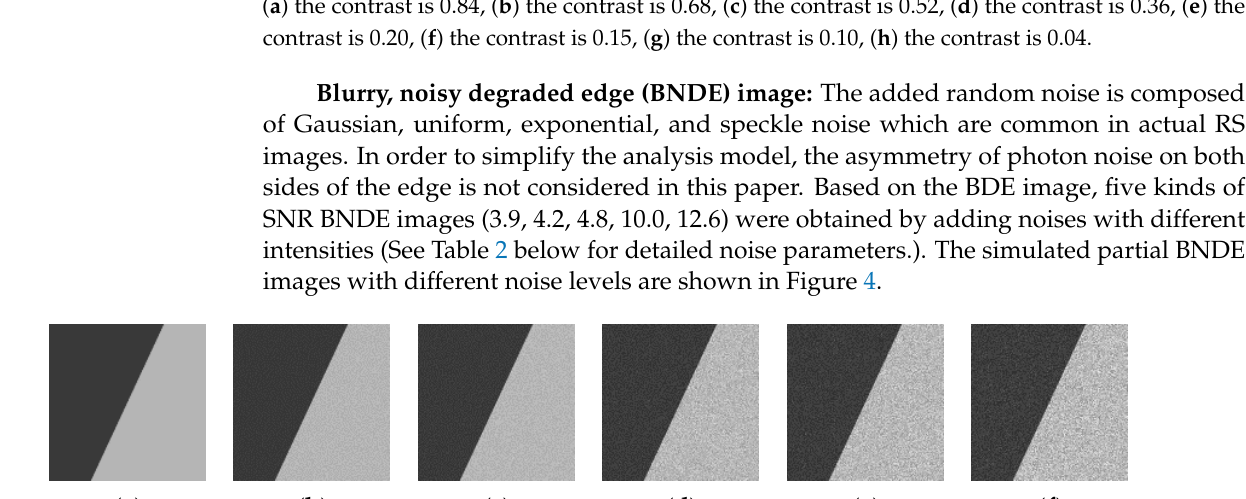
Figure 4. Partial simulated BNDF images with different SNR when the edge angle is 25 deg: ( a ) the SNR is ∞ , ( b ) the SNR is 12.6, ( c ) the SNR is 10.0, ( d ) the SNR is 4.8, ( e ) the SNR is 4.2, ( f ) the SNR is 3.9. Table 2. Noise parameter and SNR of different noise levels for different noise types.